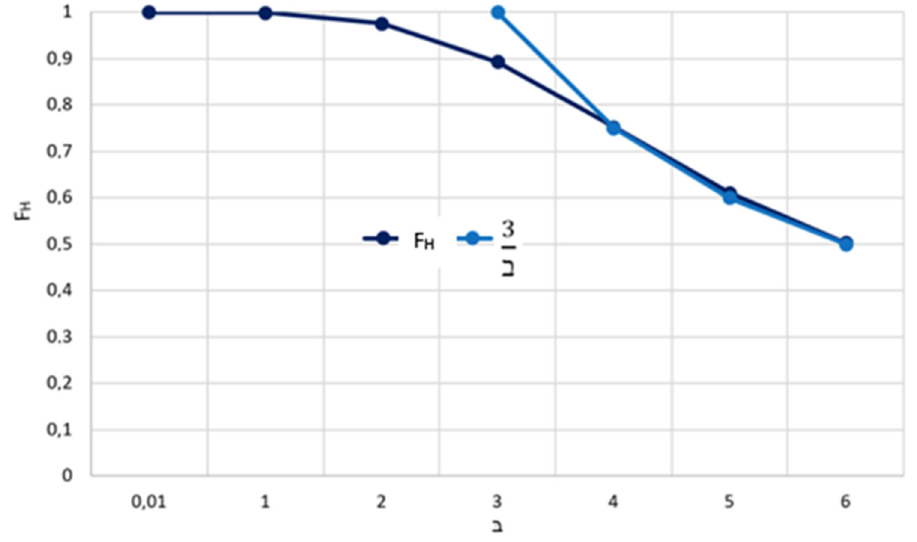
Figure 11. The function F H and 3 (cid:105)